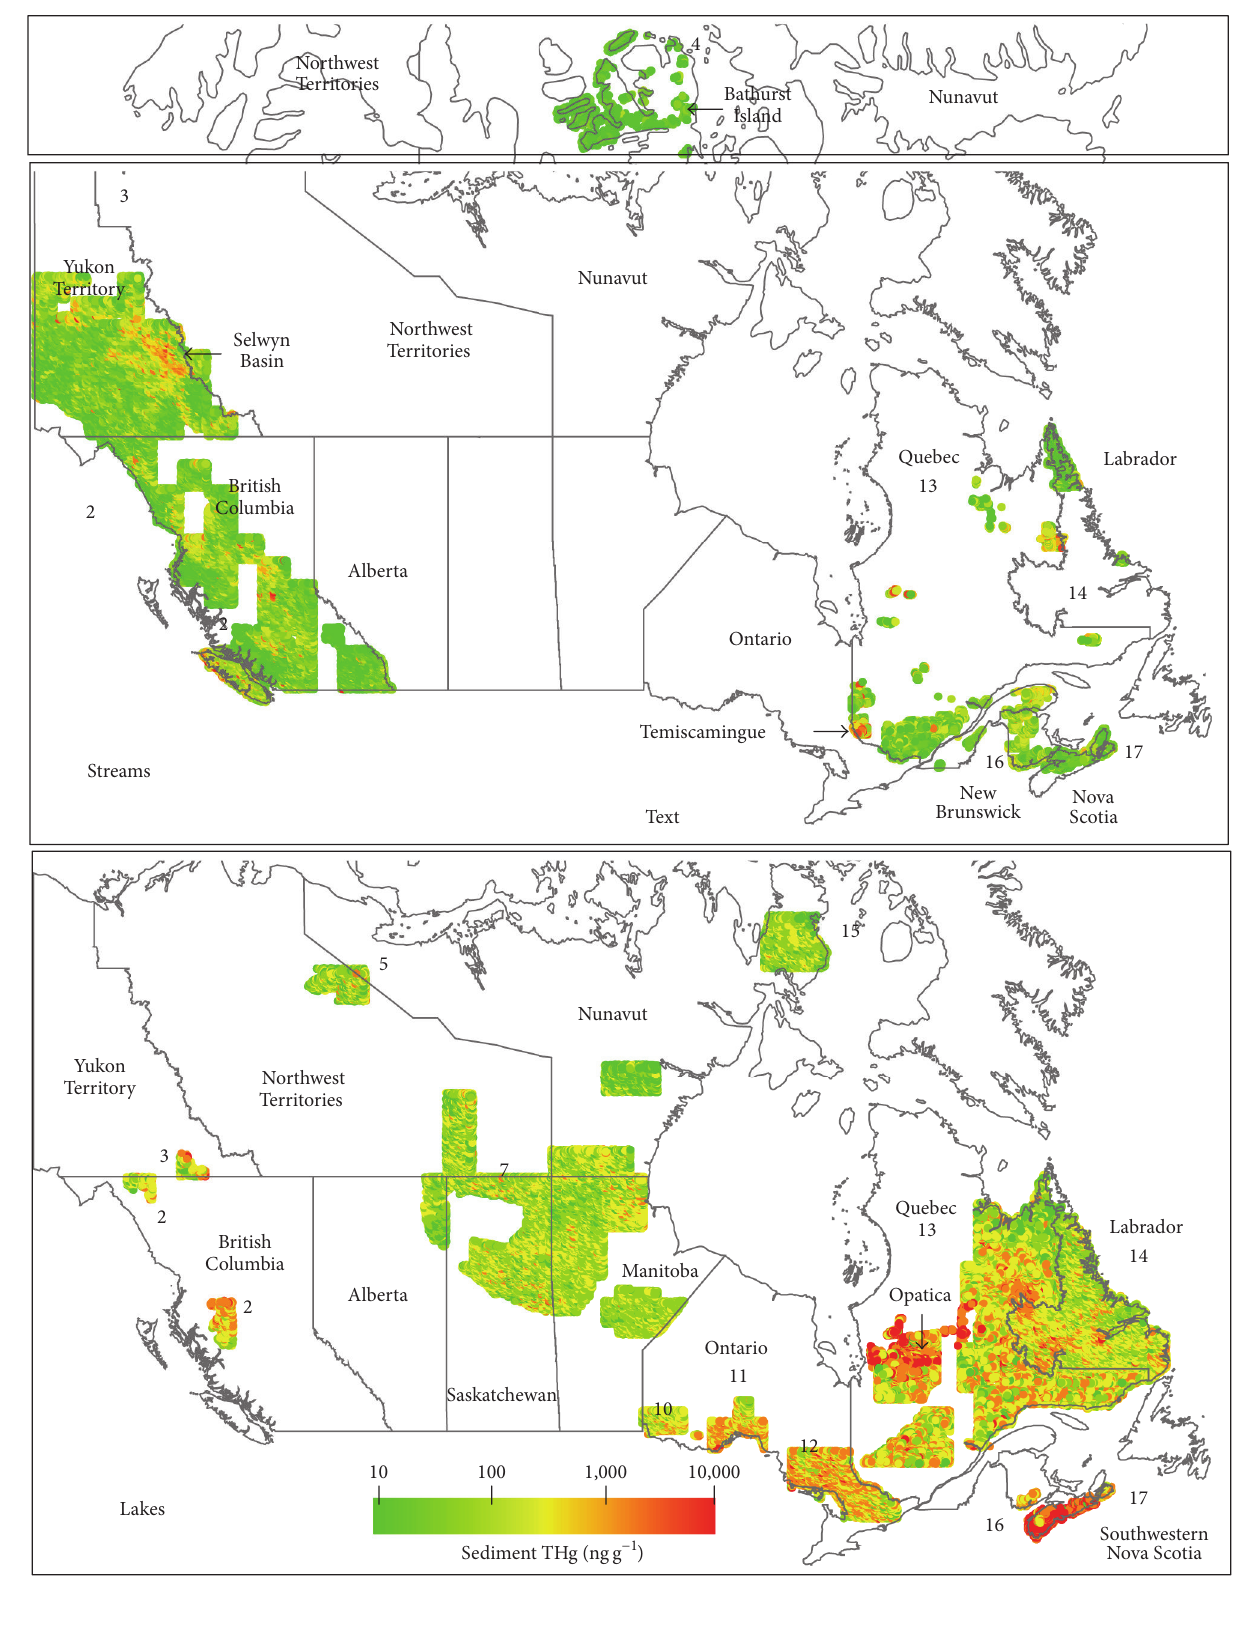
Figure 2: Point-by-point THg concentrations (ngg −1 , log 10 scale) in lake and stream sediments across Canada, as found in the open files of the Geological Survey of Canada, Quebec, and Nova Scotia. For data summary by provinces/territories and by survey zones in Quebec, see Tables 2 and 3,